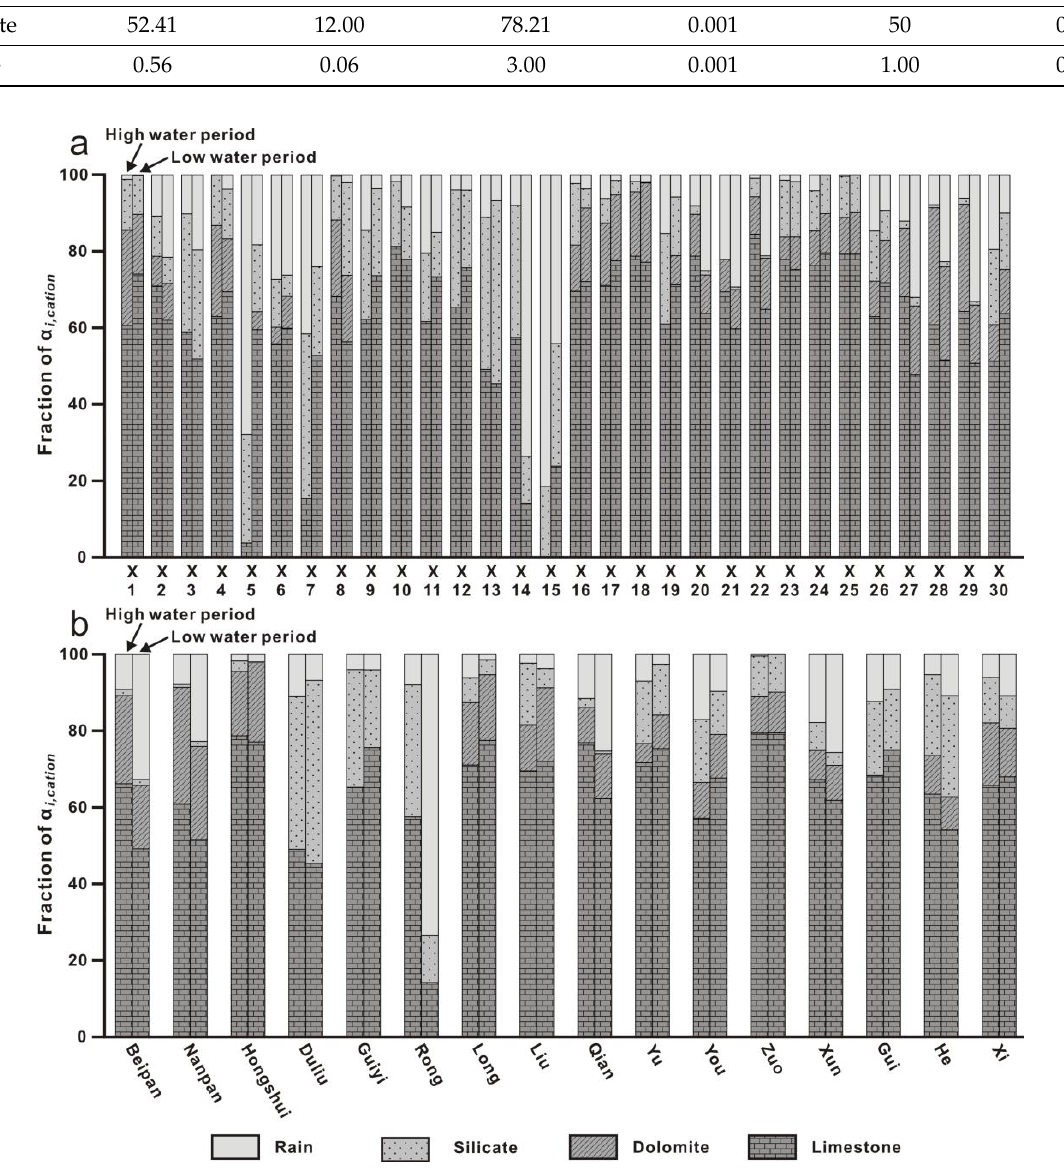
Figure 11. The fraction of total dissolved cations (α i,Catin = α i,Ca + α i,Na + α i,Mg + α i,K ) from rain, dolomite, limestone, and silicate. ( a ). The fraction of total dissolved cations in all samples. ( b ). The fraction of total dissolved cations in each subbasin. fraction of total dissolved cations in each